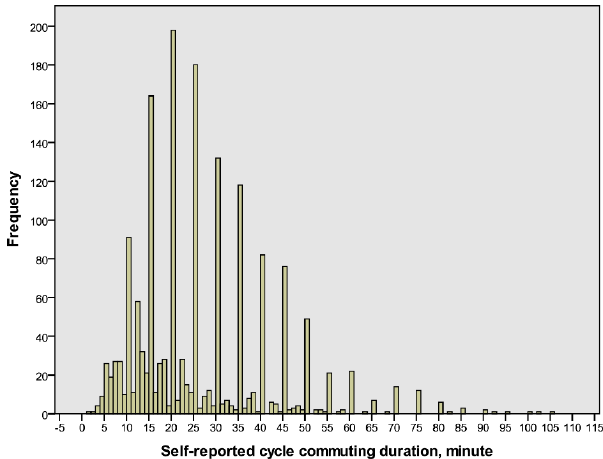
Figure 3. The frequency distribution of individual self-reported cycle commuting durations ( n = 1661). The duration values were divided into consecutively numbered clusters of last digit categories: Table 2. Expected and detected distributions of last digit categories in male and female commuter cyclists ( n = 1661). The absolute number in each group is also indicated.